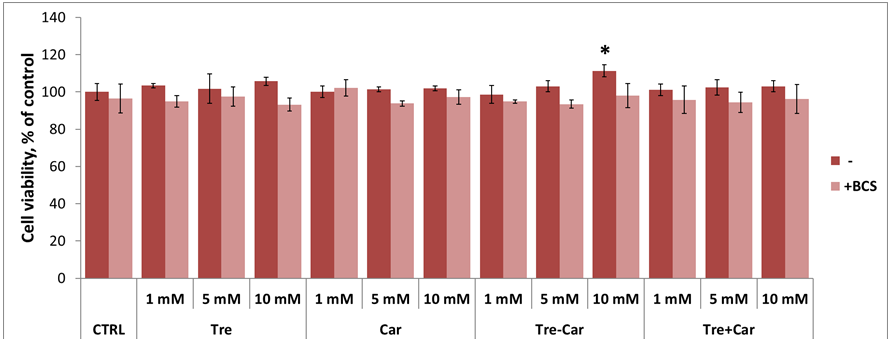
Figure 1. Dose-dependent effect of Tre, Car, Tre-Car, Tre + Car mixture and 10 µM CQ with or without 50 µM BCS on viability of PC12 cells. Cells were cultured in complete RPMI-1640 medium, seeded on L-poly-lysinated culture plates and then treated for 24 h (* p ≤ 0.05 versus control untreated cells).